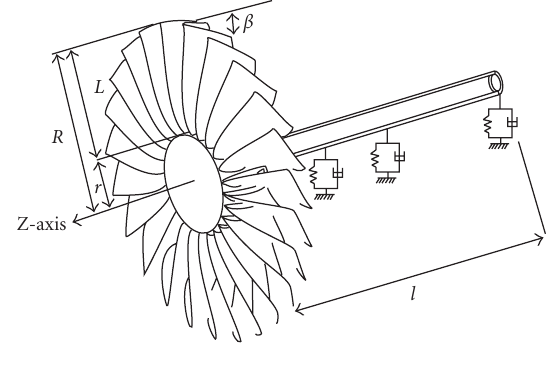
Figure 1: Model of flexible bladed rotor [9].